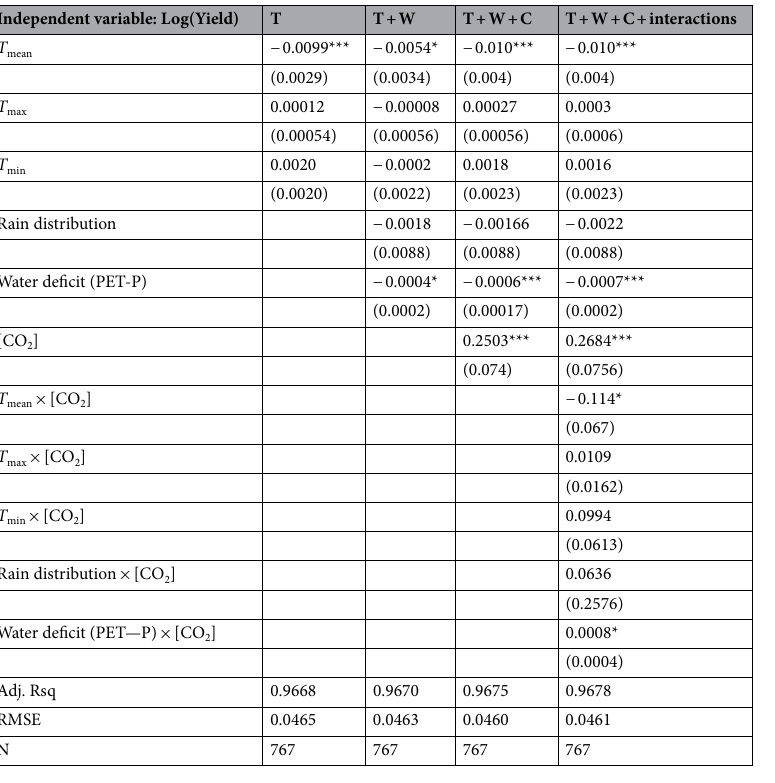
Table 1. Effects of climate variables and [CO 2 ] on log wheat yields of the world’s major wheat producers. From left to right column—T is the model with temperature variables only, T + W includes the water variables (rain distribution and water deficit as PET—P), T + W + C includes [CO 2 ], and the T + W + C + interaction model includes the combined effect of [CO 2 ] and climate variables. Standard errors are shown in parenthesis. Dependent variable is the logarithm of wheat yield. Rainfall distribution and [CO 2 ] in the models are the logarithm of the coefficient of variation in seasonal rain (standard deviation divided by the monthly mean rainfall) and the logarithm of the mean atmospheric CO 2 concentration (μmol mol −1 ) during the growing period. Stars indicate statistical significance: * p ≤ 0.1, ** p ≤ 0.05, *** p ≤